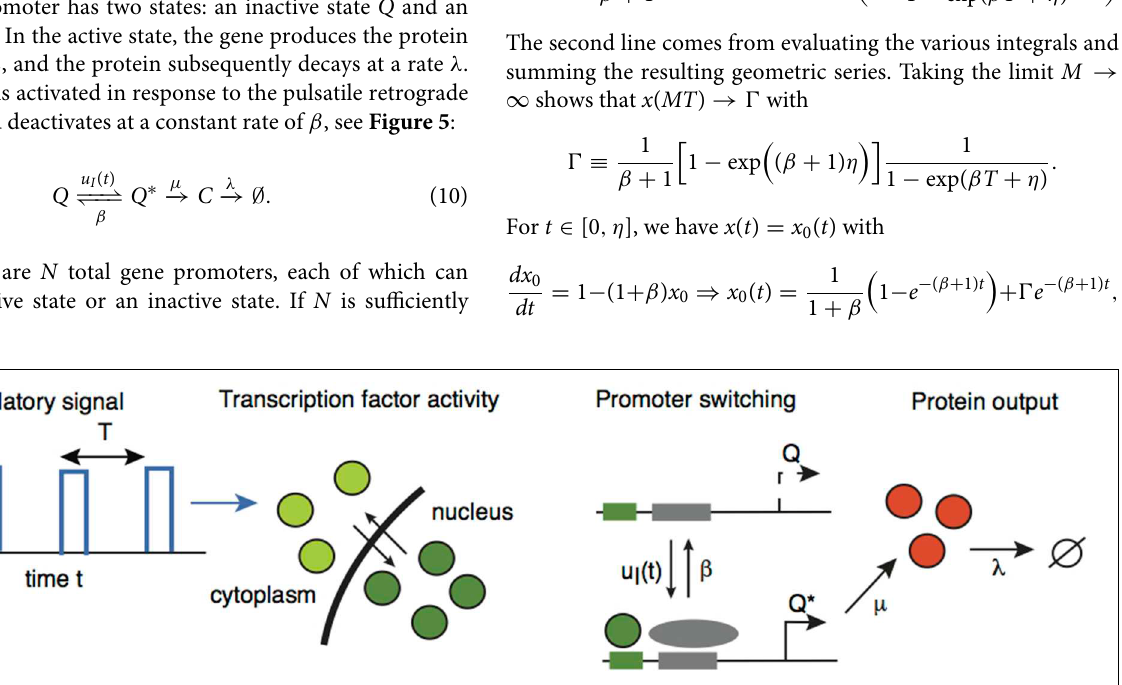
FIGURE 5 | A gene promoter driven by the oscillatory retrograde signal u I ( t ) . Adapted and redrawn from Tostevin et al. (2012).